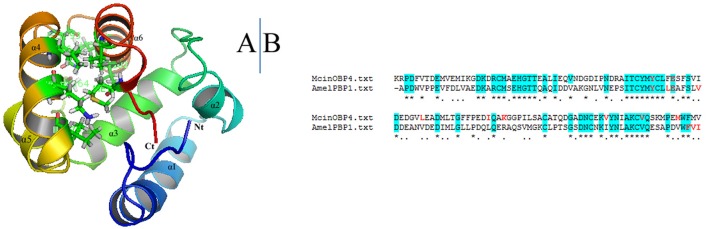
3D model structure of the McinOBP4. (A) 3D structure of McinOBP4 was built on the reference of structure of PBP1 from the Honey bee Apis mellifera. Six α-helixes, N-terminal (Nt), and C-terminal (Ct) are marked. (B) Sequence alignment of McinOBP4 and AmelPBP1.